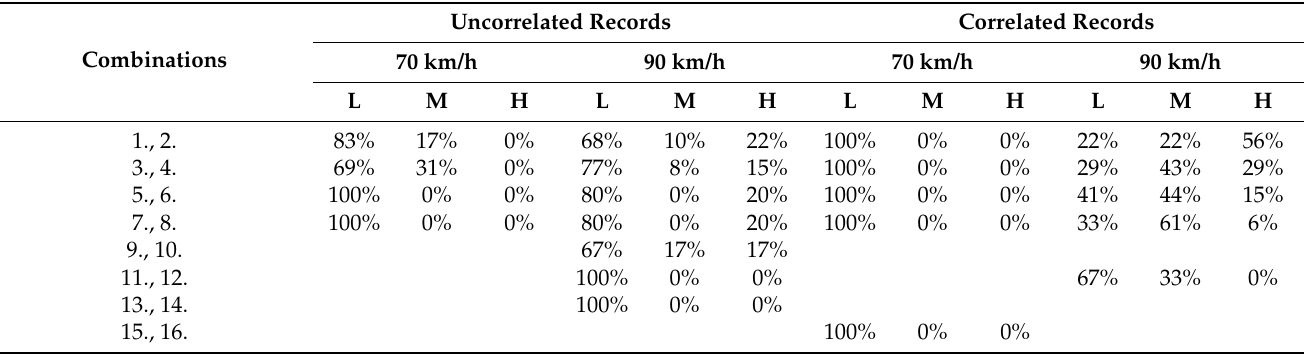
Table 8. Mutual comparison of the probability of each combination for the defect—Short